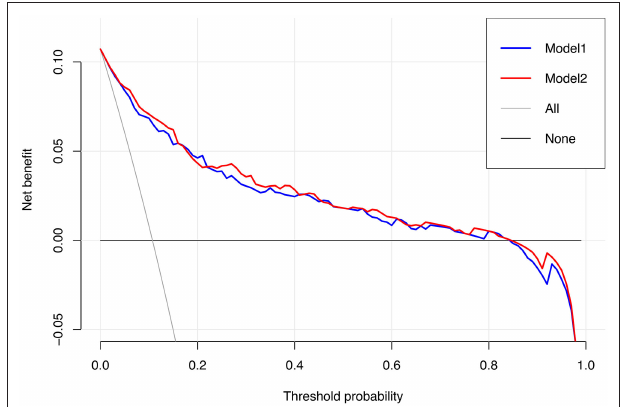
lymph node dissection, and the treat-none line represents the net benefits of giving no patient the above-mentioned surgical procedure.